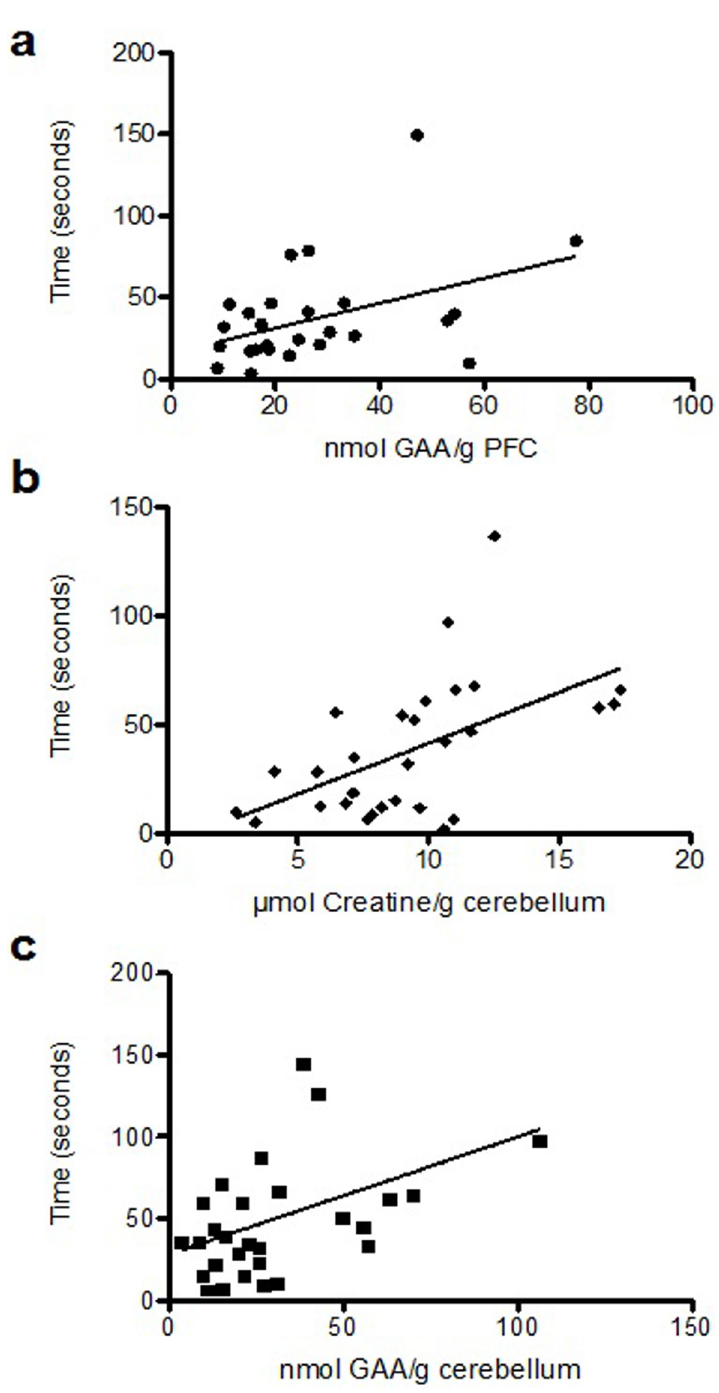
Fig 2. Regressions between brain guanidino compounds and performance. Regression analyses identified significant relationships between concentrations of GAA in the PFC and time exploring a familiar object during the 4-object test (Fig 2a), creatine in the cerebellum and time exploring a moved object during the 4-object test (Fig 2b) and GAA in the cerebellum and time exploring a novel object during the 24-hour recall test (Fig 2c).